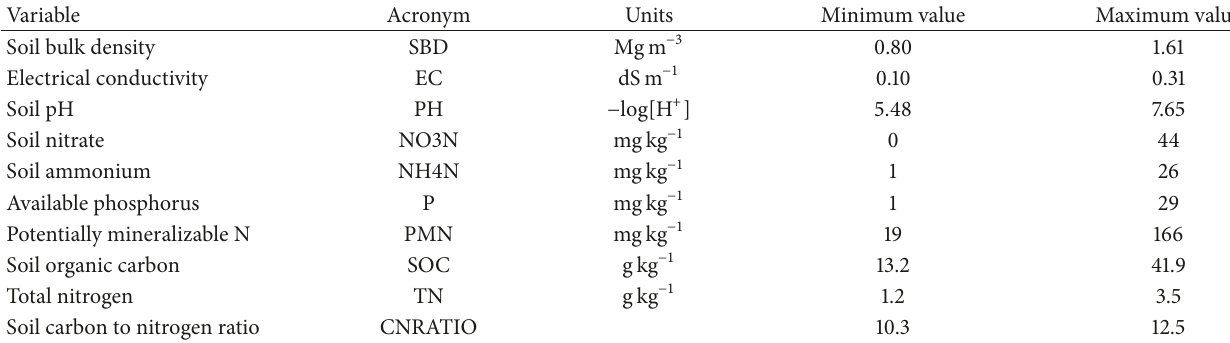
Table 1: Description of soil properties used for data